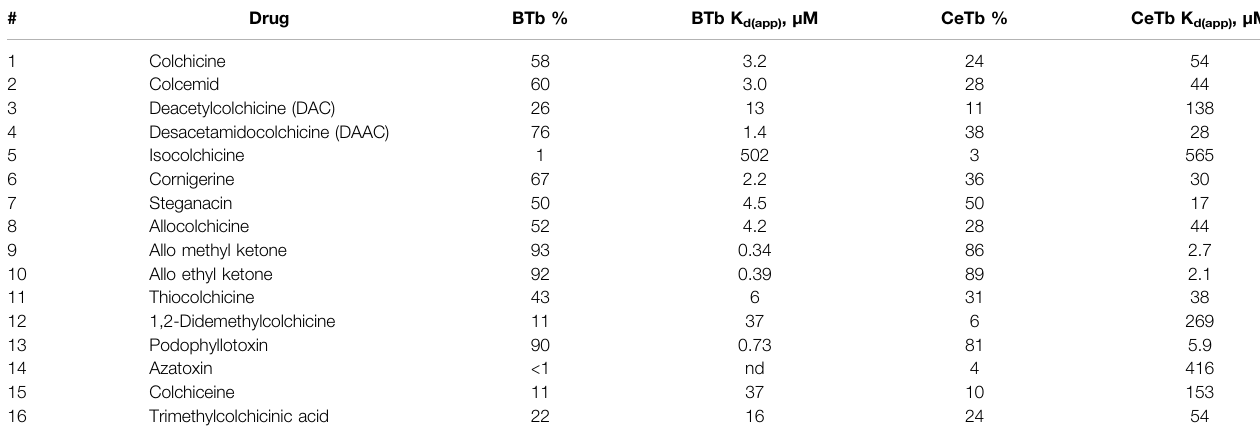
TABLE 5 | MDL competitive binding inhibition by colchicine site 3-ring drugs.